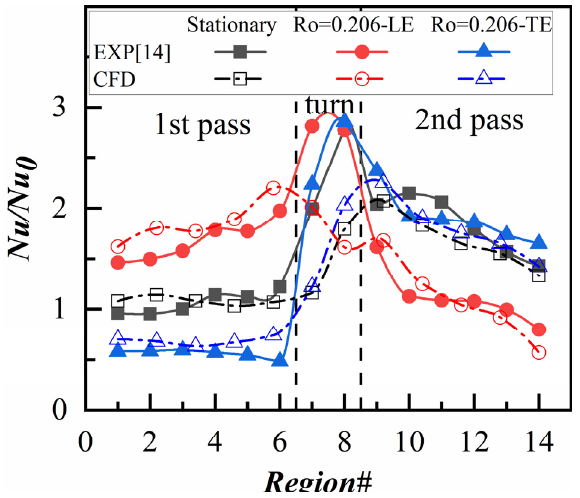
Figure 5. Experimental verification in smooth channels under stationary/rotating conditions.